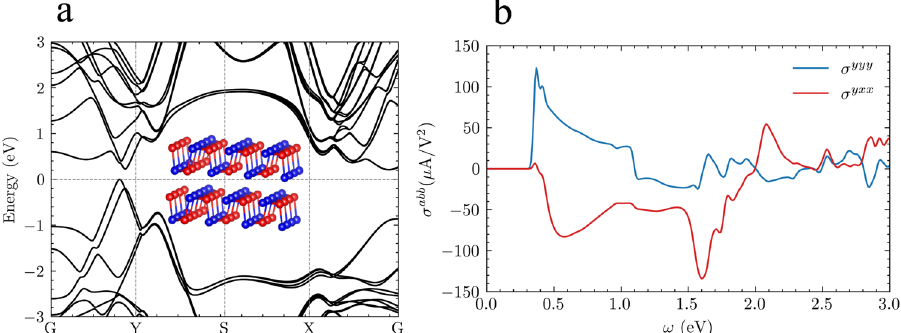
Fig. 4 Band structure and shift current in bilayer As. a Electronic band structure and b shift current σ yyy and σ yxx spectra for bilayer As calculated with HSE + SOC. The inset in a shows the structure of bilayer